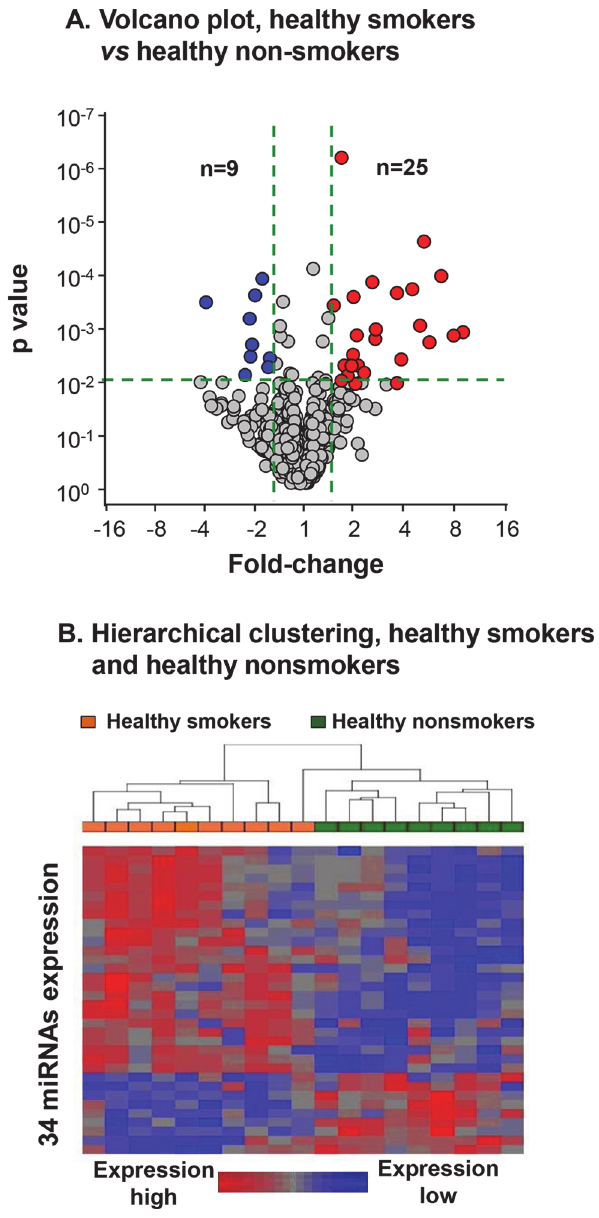
Fig 1. Volcano plot and unsupervised hierarchical clustering of differentially expressed miRNAs in the small airway epithelium (SAE) of healthy smokers and healthy nonsmokers. A. Volcano plot comparing the expression of 1100 human mature miRNAs in the SAE of smokers vs nonsmokers. There were 25 miRNAs (red) upregulated and 9 miRNAs (blue) downregulated in the SAE of healthy smokers compared to healthy nonsmokers (fold-change > 1.5, p < 0.01, total 34 miRNAs). X-axis, fold-change; Y-axis, p values. B. Unsupervised hierarchical clustering of 34 differentially expressed miRNAs between healthy smokers (tan rectangle) and healthy nonsmokers (green rectangle). The color bar indicates the relative miRNA expression